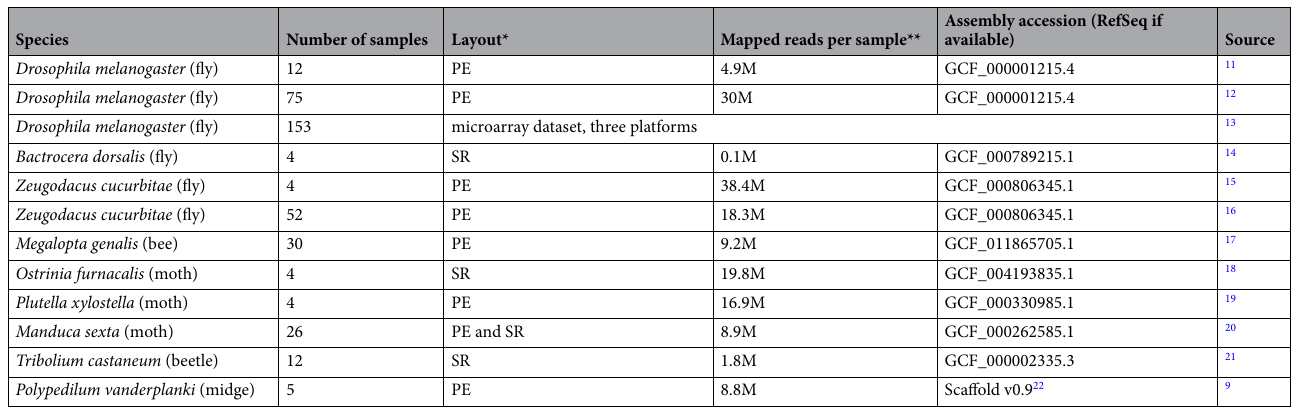
Table 1. Datasets. * RNAseq datasets have either paired-end (PE) or single-read (SR) layouts. ** The numbers of mapped reads are given in millions